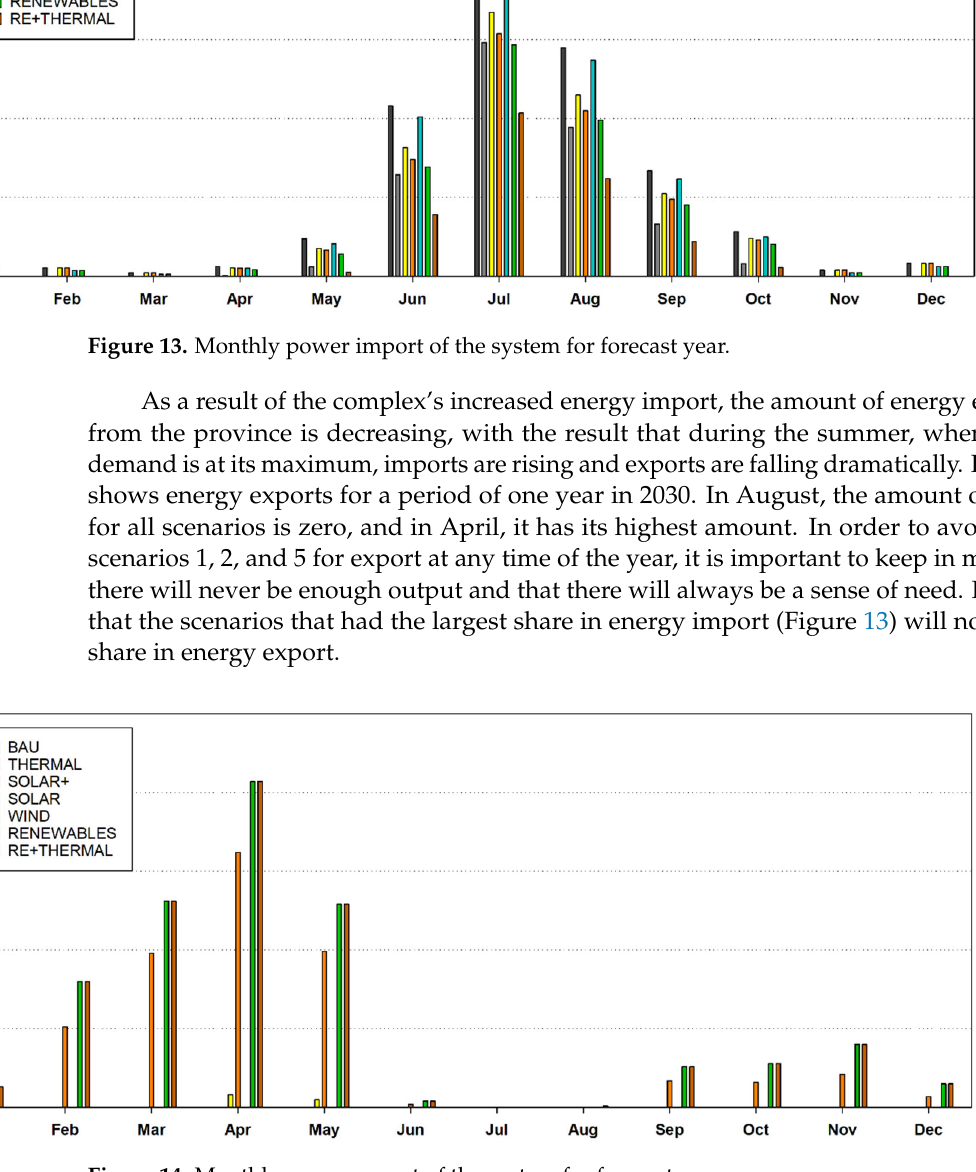
Figure 14. Monthly power export of the system for forecast year.